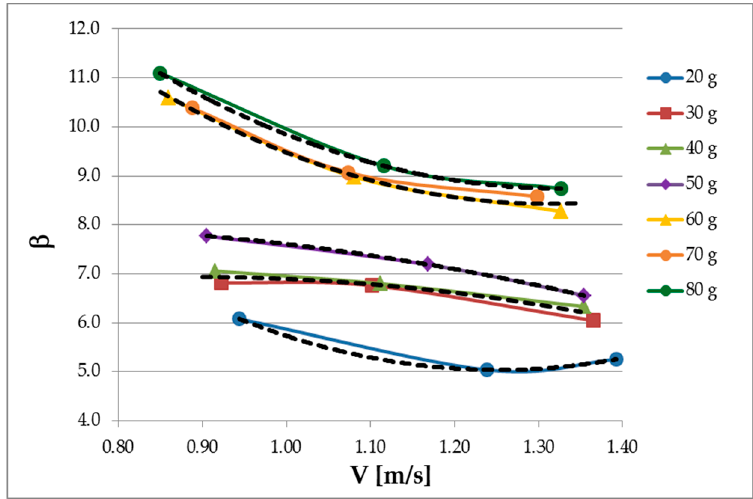
Figure 11. β –V relations with trend lines highlighted as black bold broken lines.